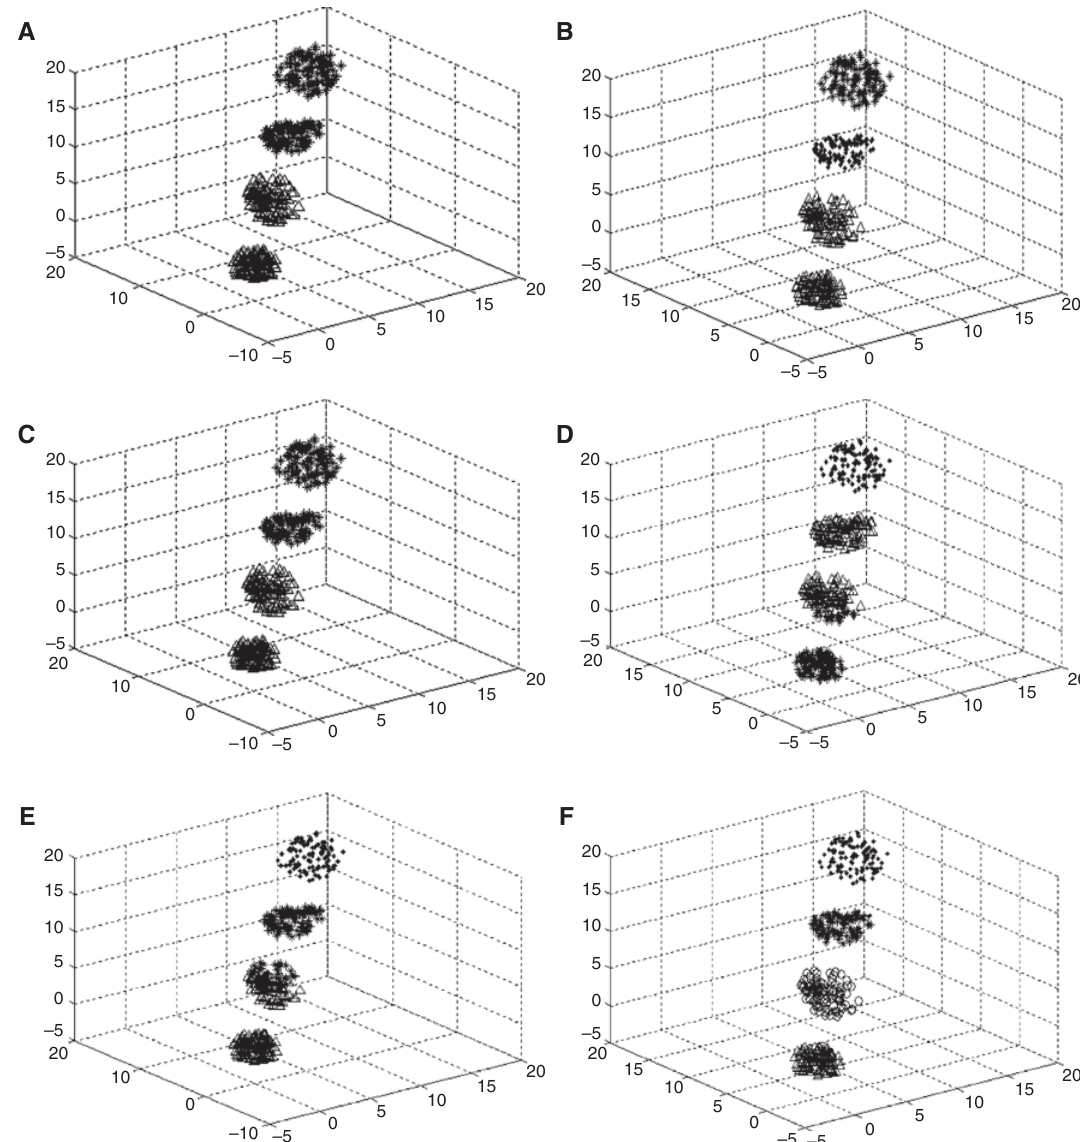
Figure 4: (A) Clustered Spherical_4_3 after the application of KM for K = 2. (B) Clustered Spherical_4_3 after the Application of KM for K = 3. (C) Clustered Spherical_4_3 after the Application of FCM for K = 2. (D) Clustered Spherical_4_3 after the Application of FCM for K = 3. (E) Clustered Spherical_4_3 after the Application of MHSC for K = 3. (F) Clustered Spherical_4_3 after the Application of MHSC for K =